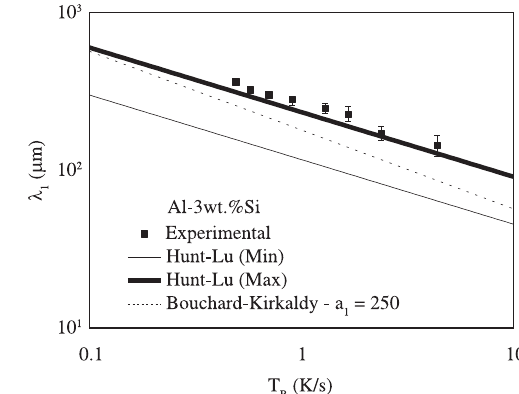
Figure 14. Comparison of experimental and theoretical primary dendrite arm spacings as a function of cooling rate for the Al- 3wt.%Si alloy in unsteady-state horizontal directional